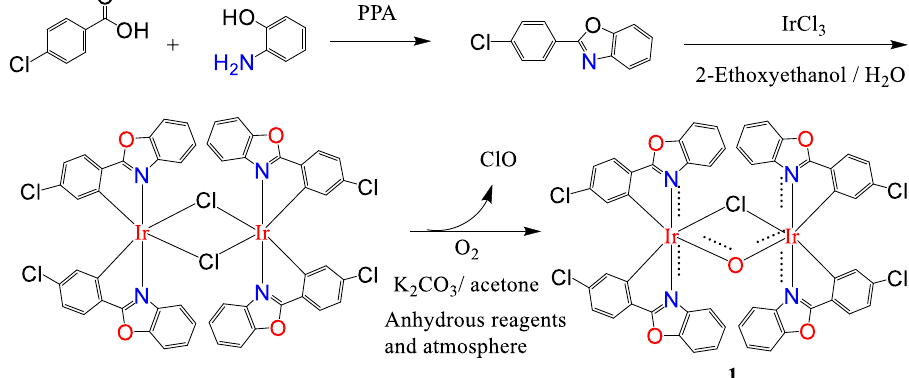
(Figure 1). The diffraction data of complex 1 was collected on a Bruker SMART APEX CCD diffractometer with graphite-monochromatized Mo K α X-ray radiation ( λ = 0.71073 Å) at 150K. All calculations for the structure determination were carried out using SHELXTL package (version 5.1). The positions of the heavy atoms, including the iridium atoms, were located by the direct method. The remaining atoms were found in a series of alternating difference Fourier maps and least-square refinement [6]. Crystal data for compound 1: